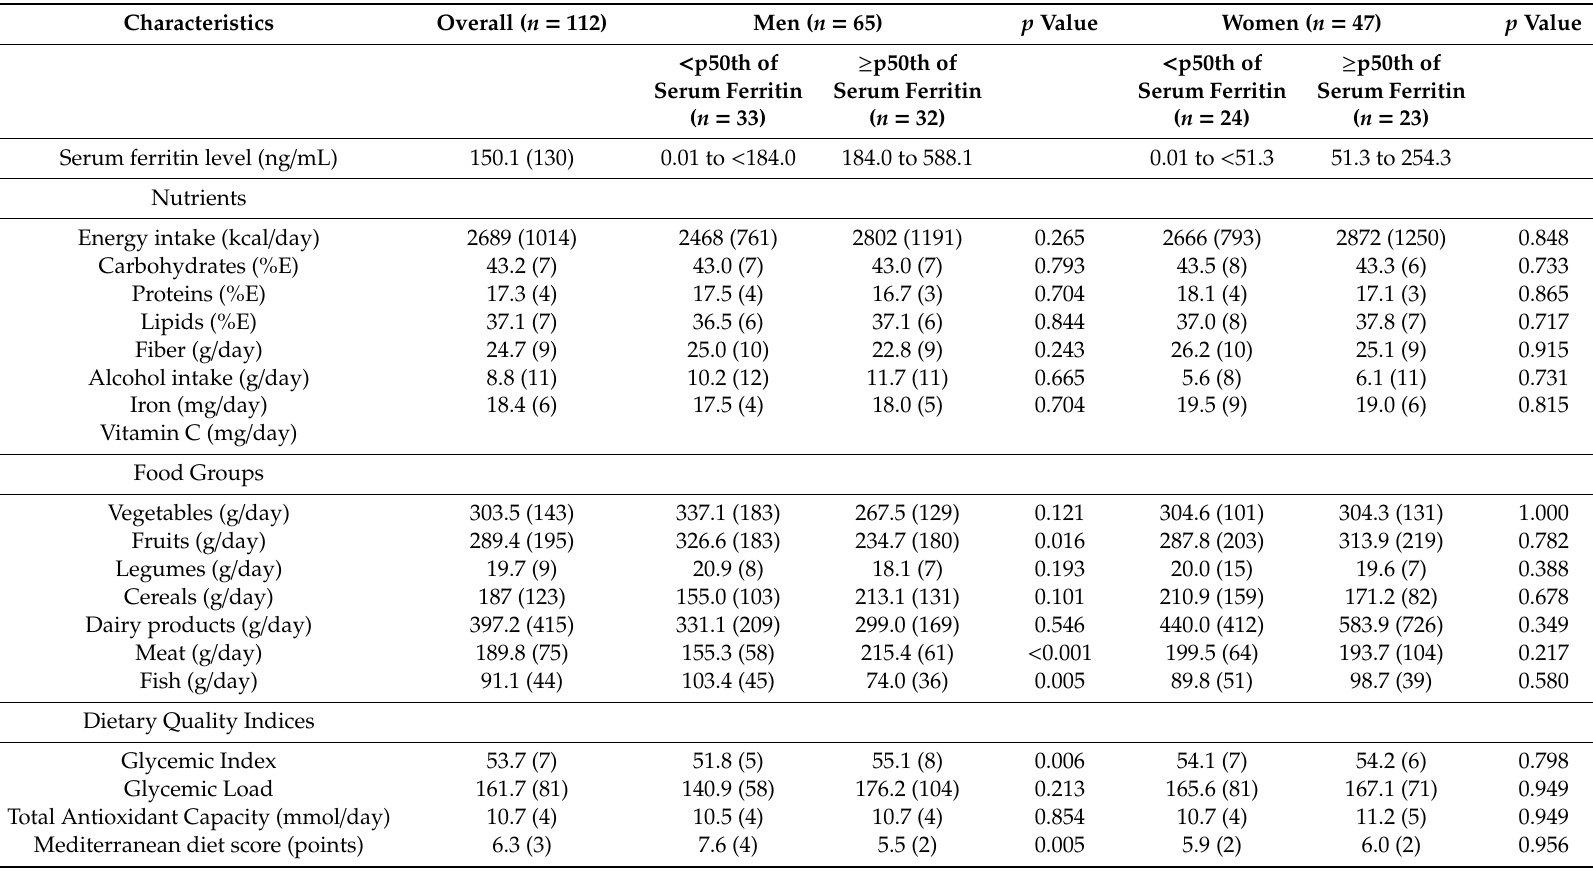
Table A2. Description of the nutrient and food consumption according to p50th of serum ferritin for men and women, respectively.